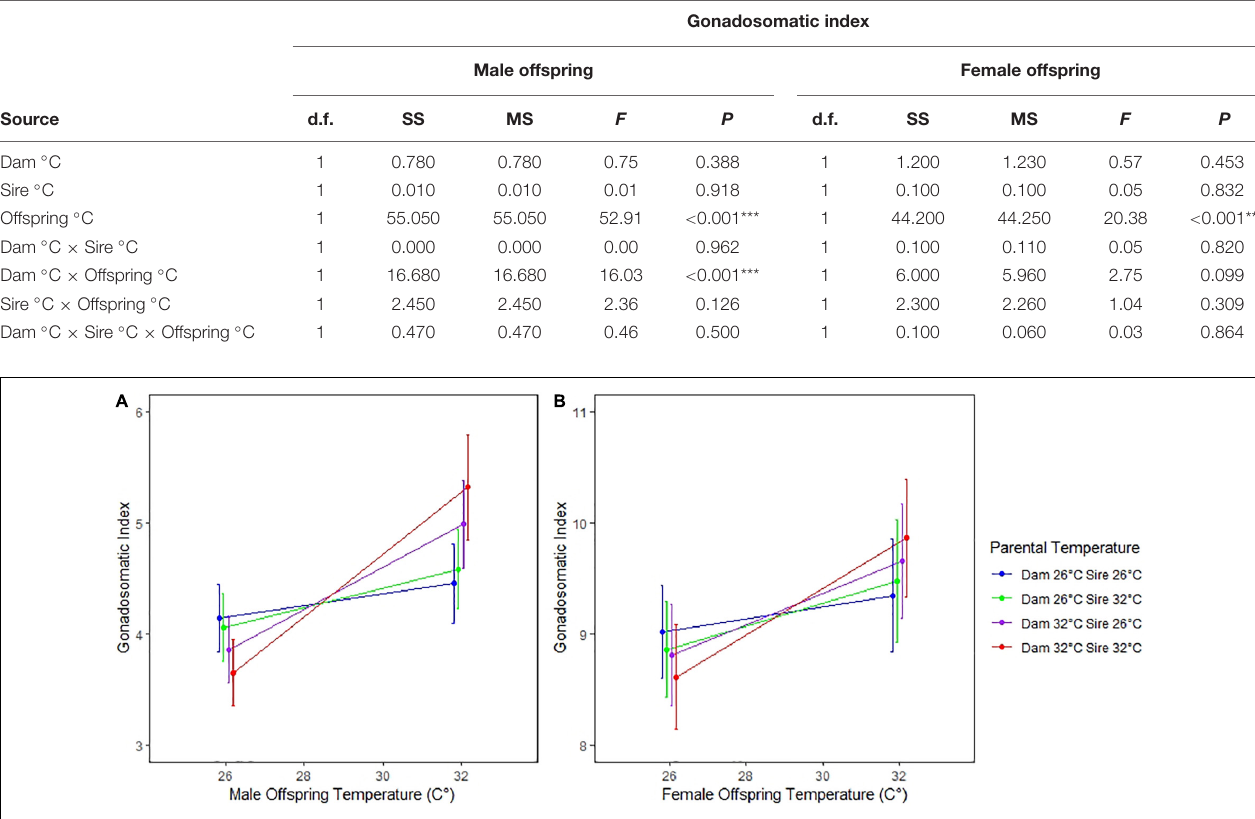
FIGURE 2 | (A) Gonosomatic index for male offspring versus offspring temperature ( ◦ C). (B) Gonosomatic index for female offspring versus offspring temperature ( ◦ C). The red line indicates GSI for offspring whose sire and dam were both at 32 ( ◦ C). Similarly, the purple, green, and blue lines correspond to dam/sire temperatures of 32/26, 26/32, and 26/26, respectively. Note that the GSI is largest (hence maturation fastest) for offspring whose parents were both at the same temperature. Error bars denote 95% confidence